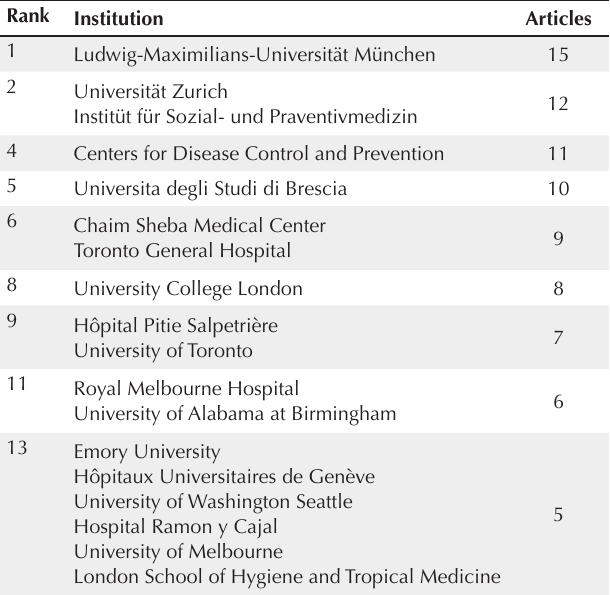
Table 6. Institutions Publishing in the Most Cited Articles in Travel Medicine